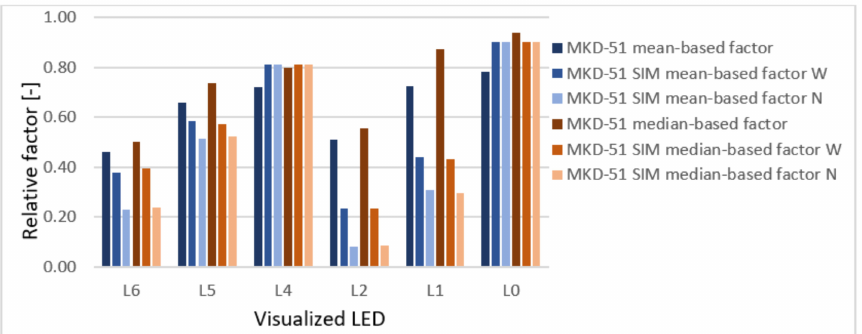
Figure 8. Comparison of LED normalized compound brightness factors with (W) and without (N) brightness compensation for 0%, 10%, 30%, and 100% duty cycle of PWM scheme.